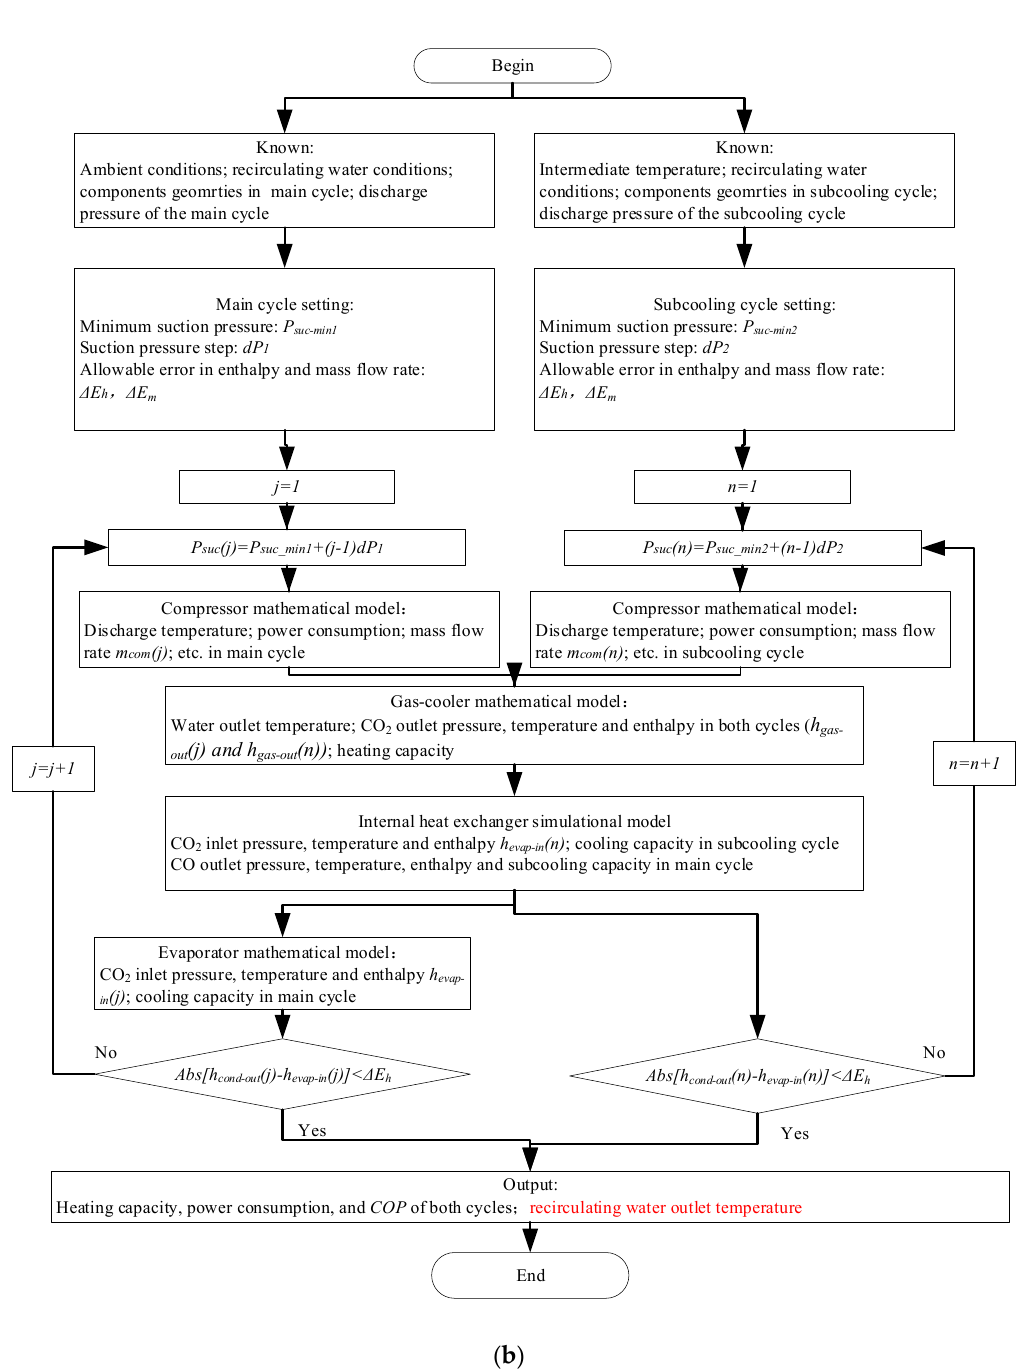
Figure 2. ( a ) The process of the dual optimal discharge pressure-seeking; ( b ) the process of the dual system’s thermodynamic simulation.